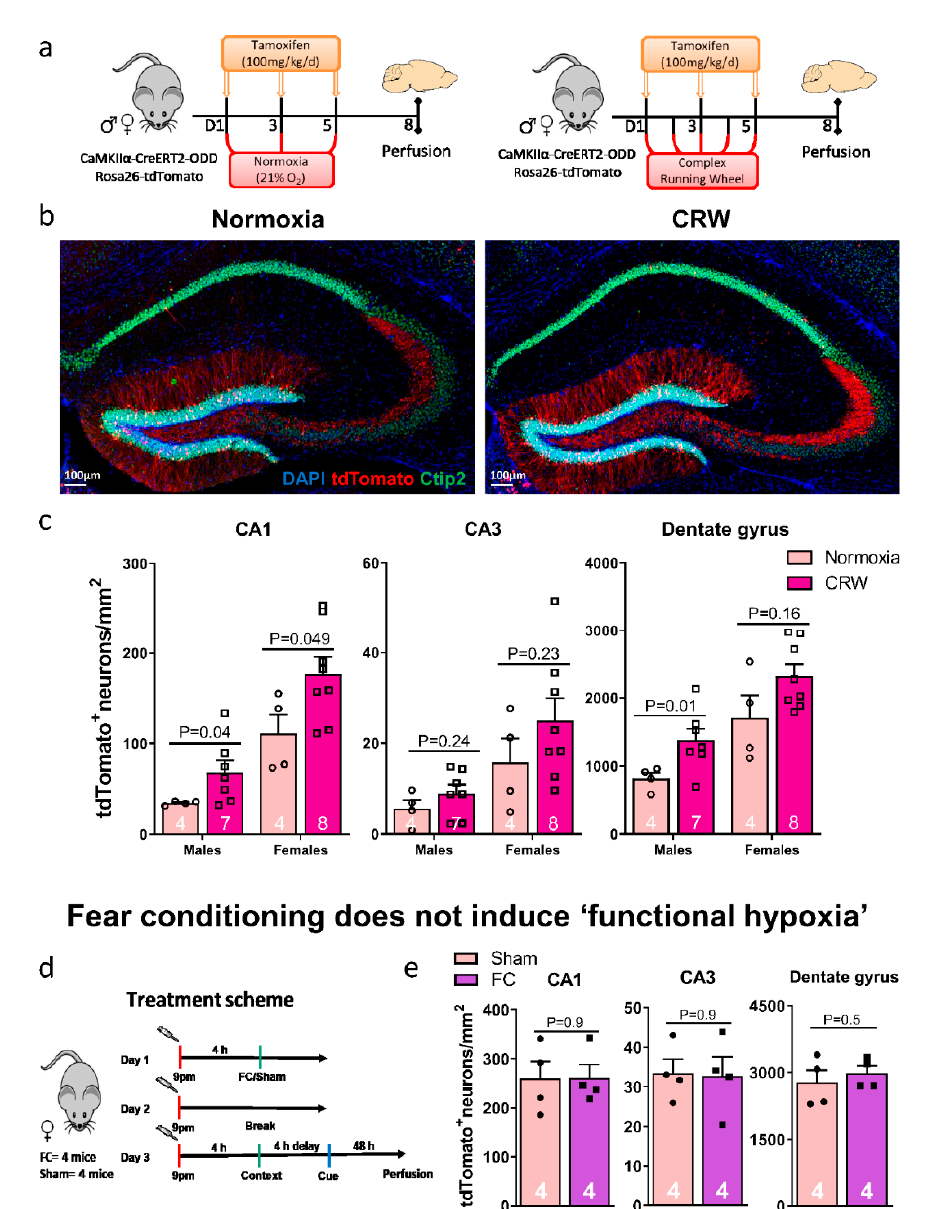
Figure 4. Complex motor-cognitive challenge as inducer of ‘functional hypoxia’ in the hippocampus. ( a ) Experimental design: mice with no prior training were given free access to complex running wheels (CRW) for five complete days and received tamoxifen injections every other day (three in total). Normoxia mice obtained the same treatment but were kept in standard cages. All mice were perfused on day eight and brains collected for histology. ( b ) Representative hippocampus images from eight-week-old female CRW-exposed and normoxia mice; scale bar 100 µ m. ( c ) Quantifications of tdTomato+/Ctip2+ neurons in CA1, CA3, and dentate gyrus revealed an increase upon exposure to CRW in both genders, with normoxia and CRW values considerably more pronounced in females. ( d ) Experimental design of the fear conditioning (FC) pilot experiment (24-week-old females). ( e ) Quantification of tdT+/Ctip2+ neurons in hippocampal CA1, CA3, and dentate gyrus regions of sham and FC mice indicate no noteworthy difference. This is likely due to the FC stimulus being too short-lived to evoke functional hypoxia. Unpaired Student’s t -test (two-tailed, Welch’s corrections); n numbers given in graphs; error bars indicate standard error of mean (SEM).